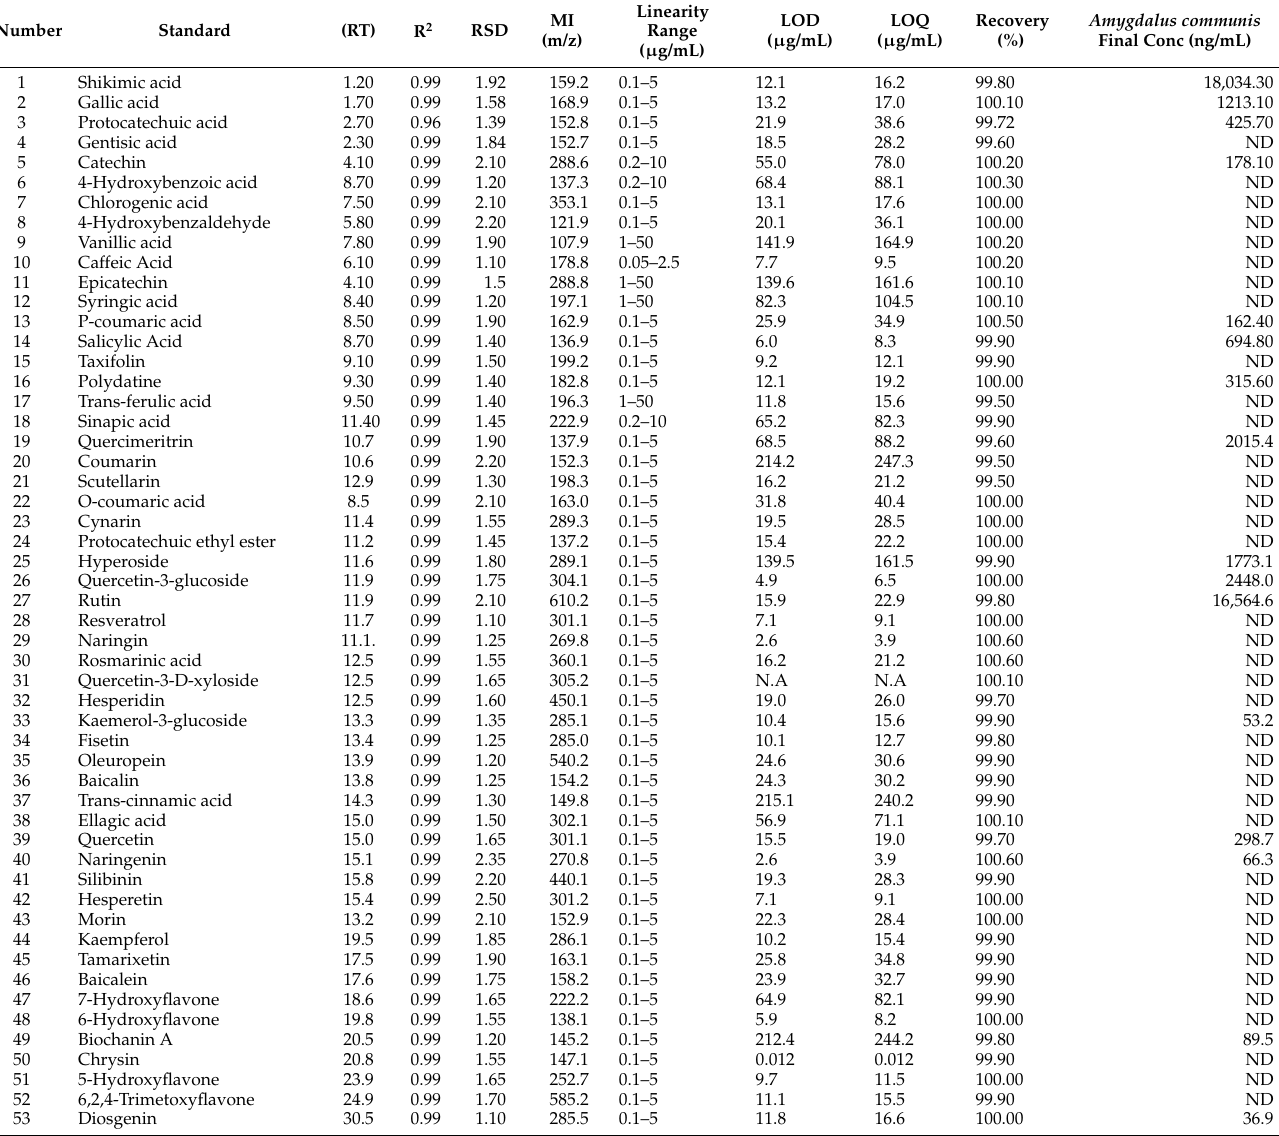
Table 1. LC-MS/MS quantitation results of Amygdalus communis methanol